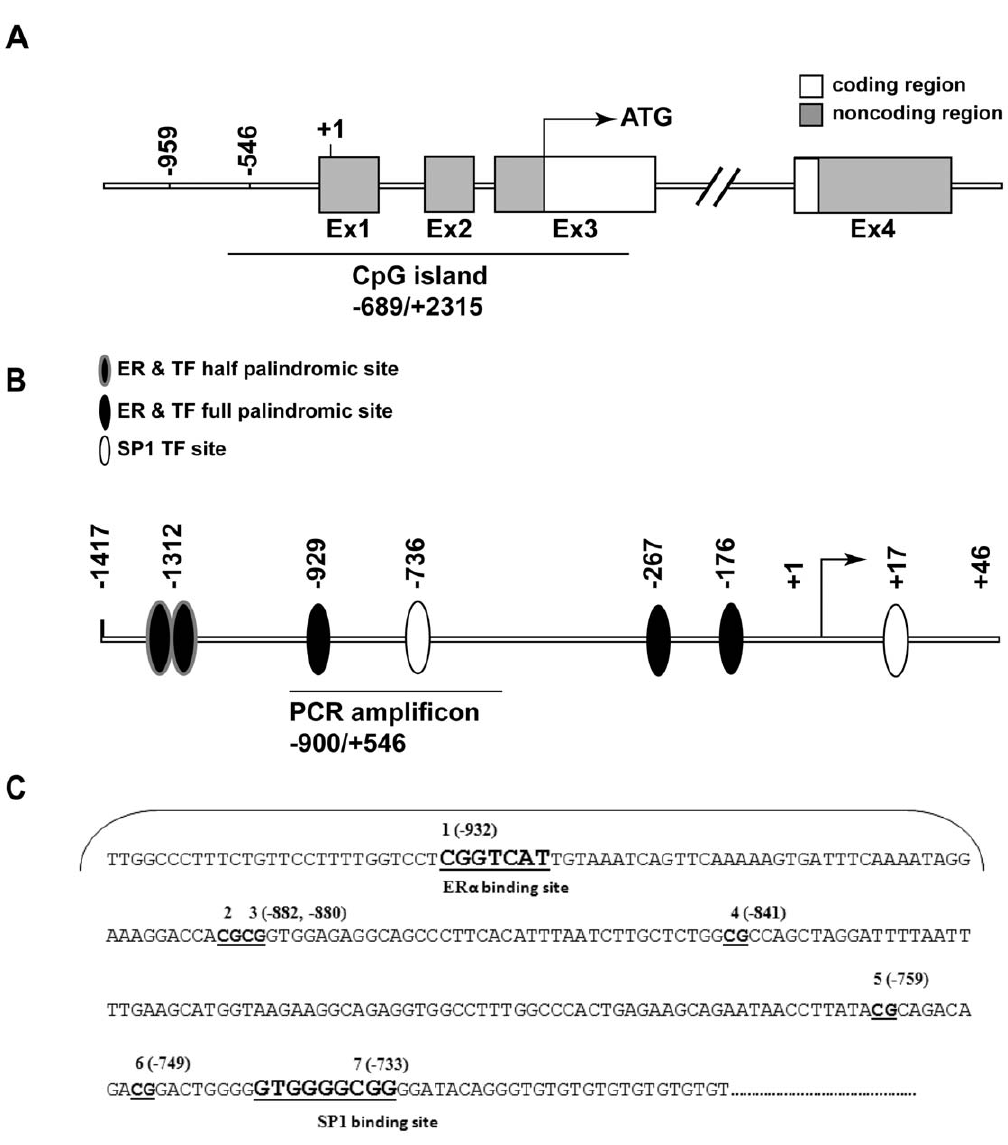
Figure 1. The general structure of the mouse Oxtr gene and its promoter. A ) A schematic depiction of the mouse Oxtr gene, including the CpG island that extends from the promoter into the coding region at the third exon. B ) A schematic depiction of the EREs and SP1 binding sites in the minimal gene promoter, and the relative location of the PCR amplicon between positions 2 956 and 2 541. C ) The sequence of the PCR amplicon, including the positions of the seven CpG sites. The ERE harboring CpG site 1 and the SP1 binding sequence harboring CpG site 7 are